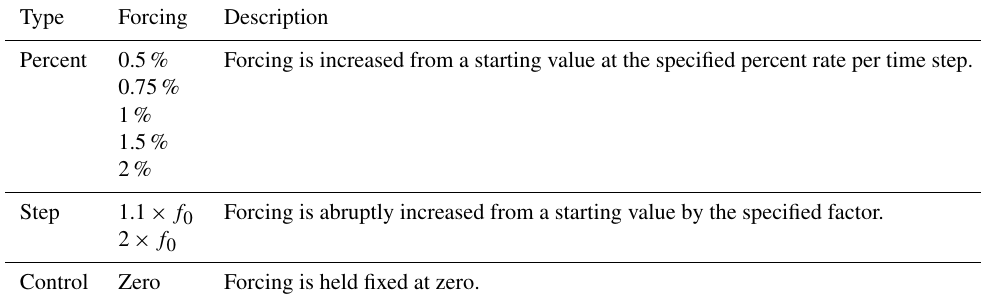
Table 2. Experiments considered in this study. Forcings are shown in Fig. 2. To standardize the types of experiments considered here and in Part 2, we select forcing functions that mimic those employed in climate change simulation experiments to whose data the RFI method is applied in Part 2. Note that in principle any type of forcing could be